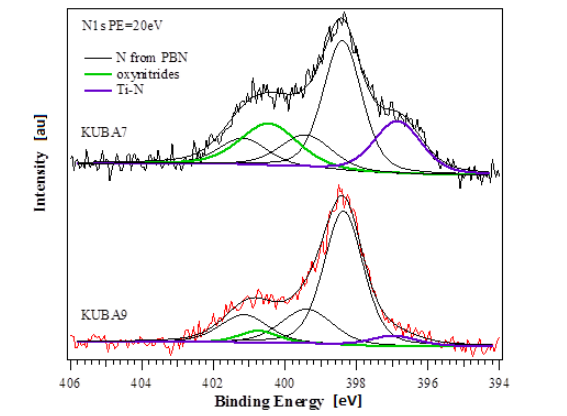
Figure 13. XPS spectra close to N1s line observed for the K7 and K9 samples; experimental values (the noisy courses) and the fit curves are shown. For more details see